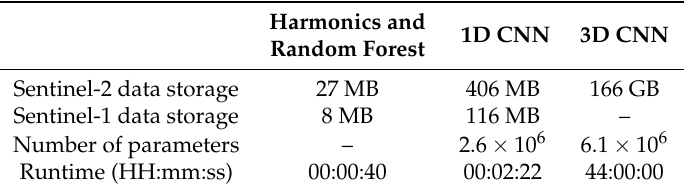
Table A3. Data storage and computational runtime required of the 3 machine learning algorithms. Data storage is shown for 10,000 samples. Experiment runtimes are shown for the 3-class task for training and validating on a single model. Random forest experiments were performed using sklearn ’s RandomForestClassifier with 500 trees on 8 CPUs with 52 GB RAM running Ubuntu 16.04. The CNNs were run on the same machine on one NVIDIA Tesla K80 GPU, and runtimes are shown for 20 epochs.